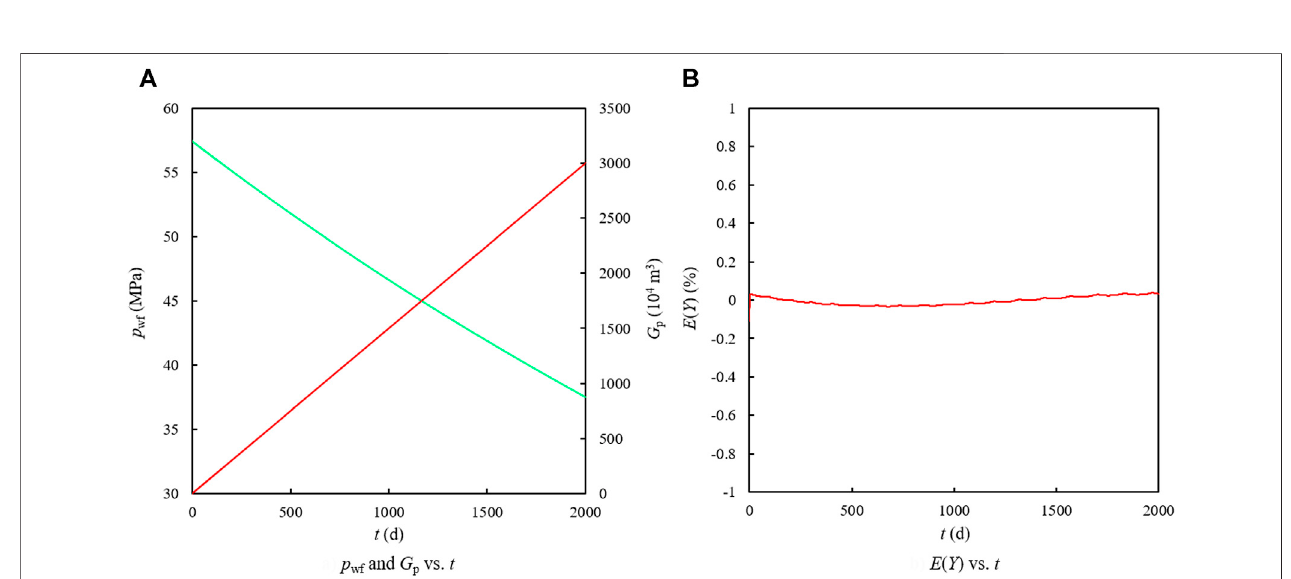
FIGURE 7 | p wf , G p and E ( Y ) vs. t for the constant-rate case.